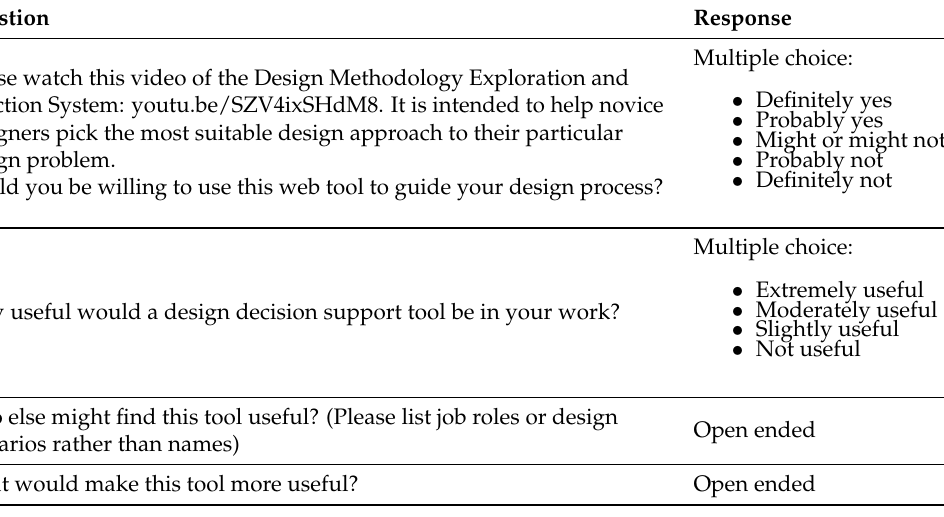
Table A2. Questions about decision support